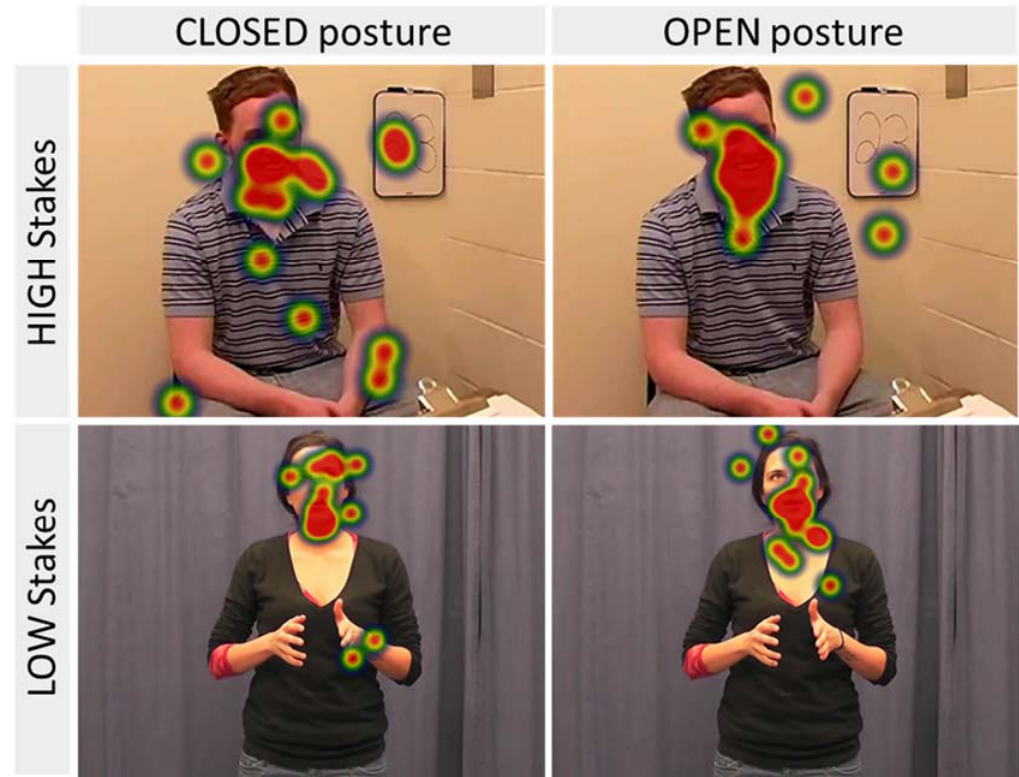
Figure 2. Eye-gaze heat maps for looking frequency of Closed and Open posture judges looking at the High-Stakes and Low-Stakes videos. All subjects agreed to the publication of their images.